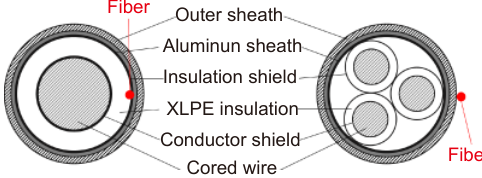
Fig. 13 | Fiber deployment inside or outside electrical cable. (Figure redrawn after ref. 120